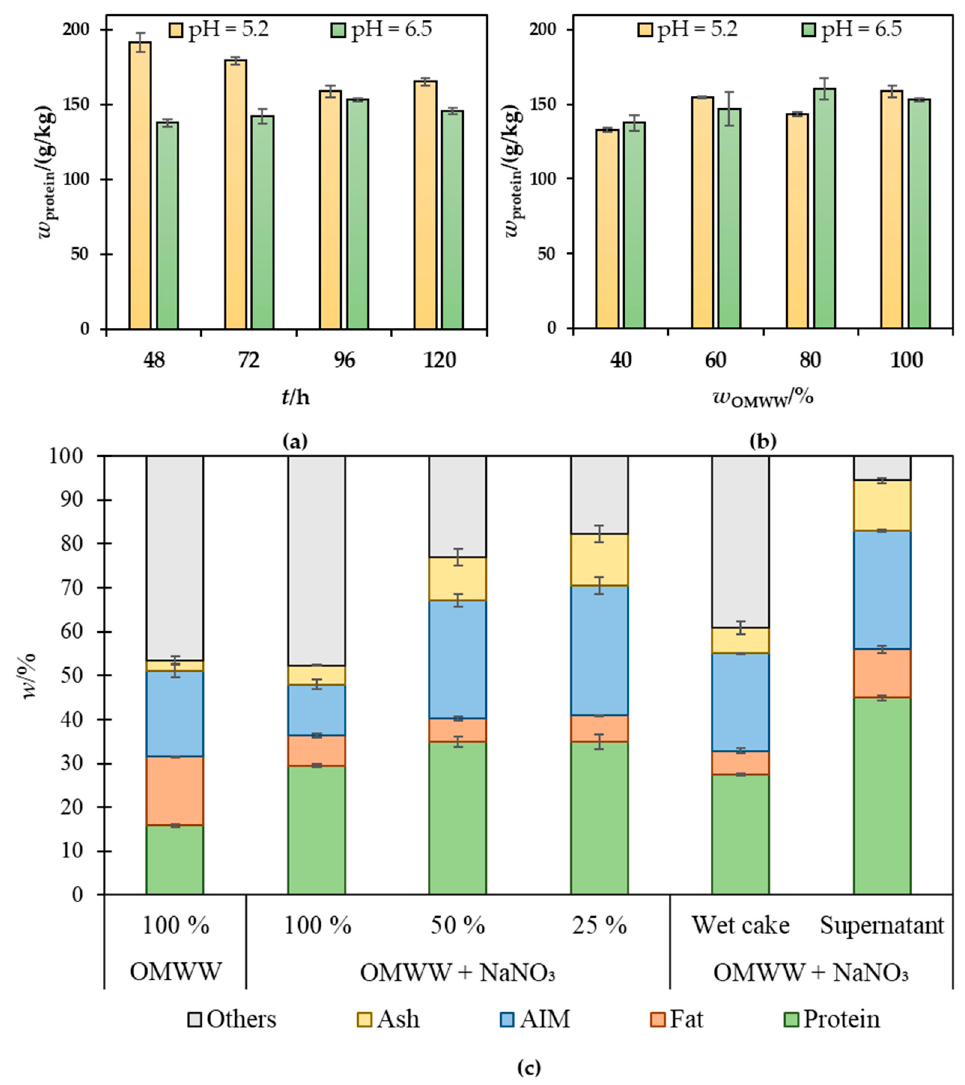
Figure 5. ( a )Protein content of A. oryzae biomass obtained after cultivation in undiluted OMWW at initial pH of 5.2 and 6.5; ( b ) Protein content of A. oryzae biomass obtained after cultivation in OMWW at different mass concentrations and at initial pH of 5.2 and 6.5; ( c ) composition of A. oryzae biomass obtained at different cultivation conditions.